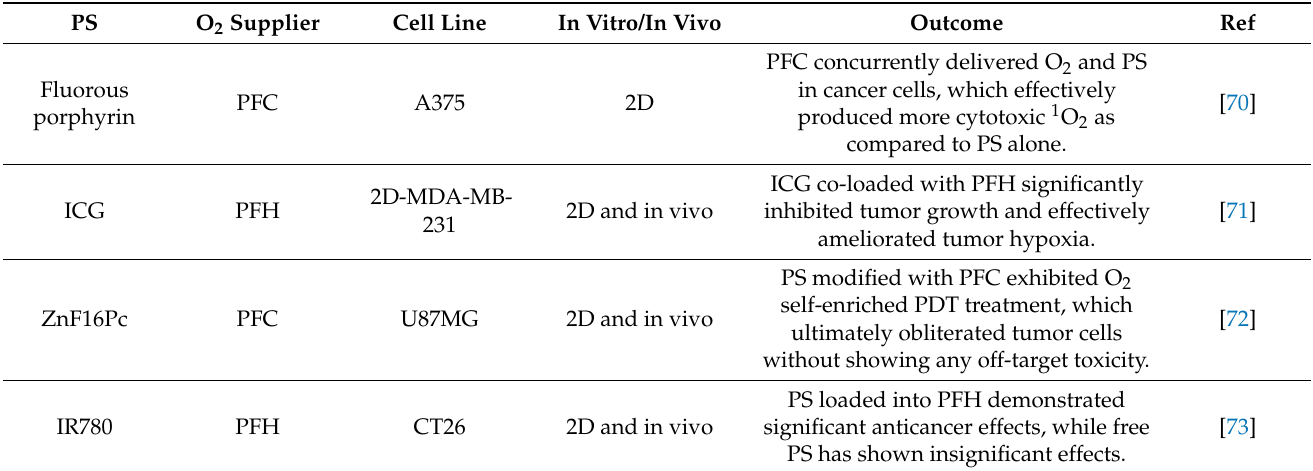
Table 3. An overview of studies that have used PFCs for O 2 supply in